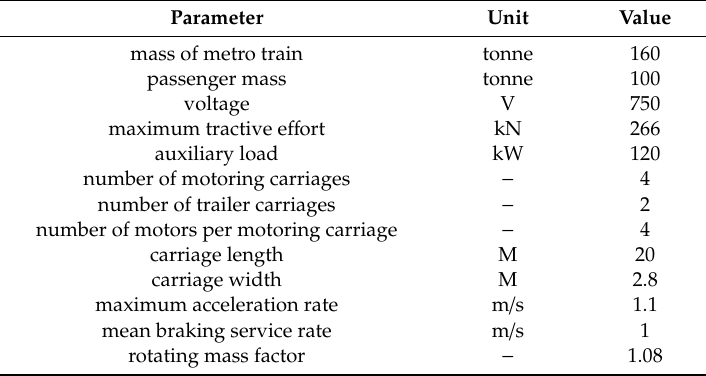
Table A6. Metro train input parameters.